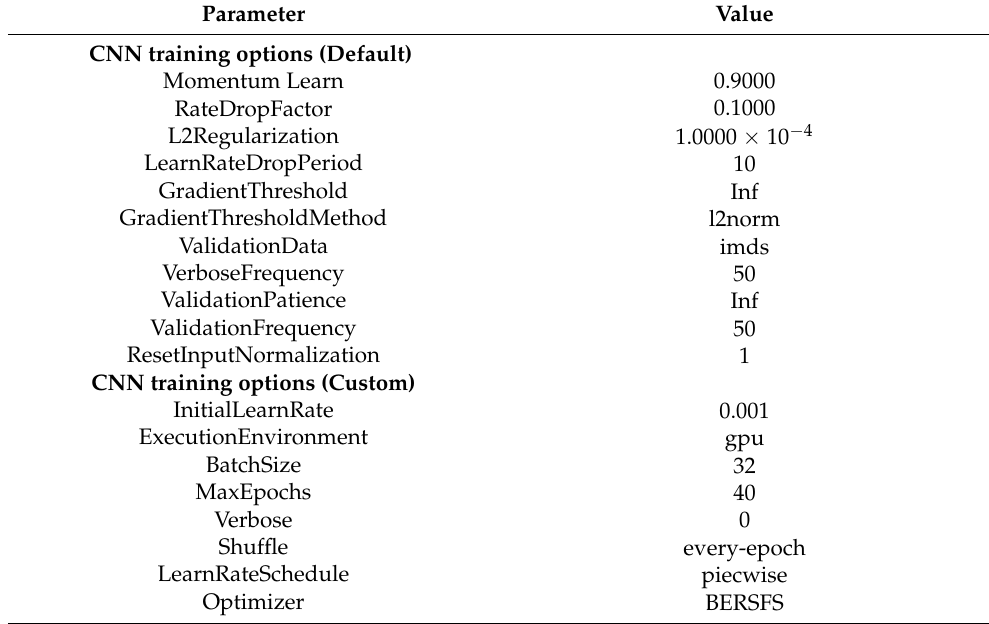
Table 2. Parameters of the experimental CNN